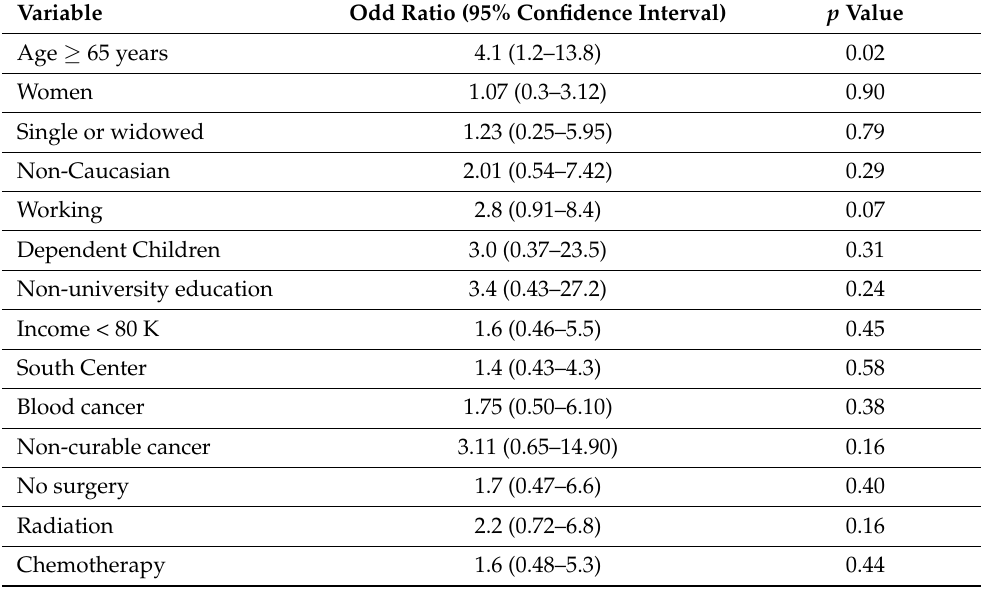
Table 6. Univariate analysis of association between a positive telehealth experience and various socioeconomic and demographic